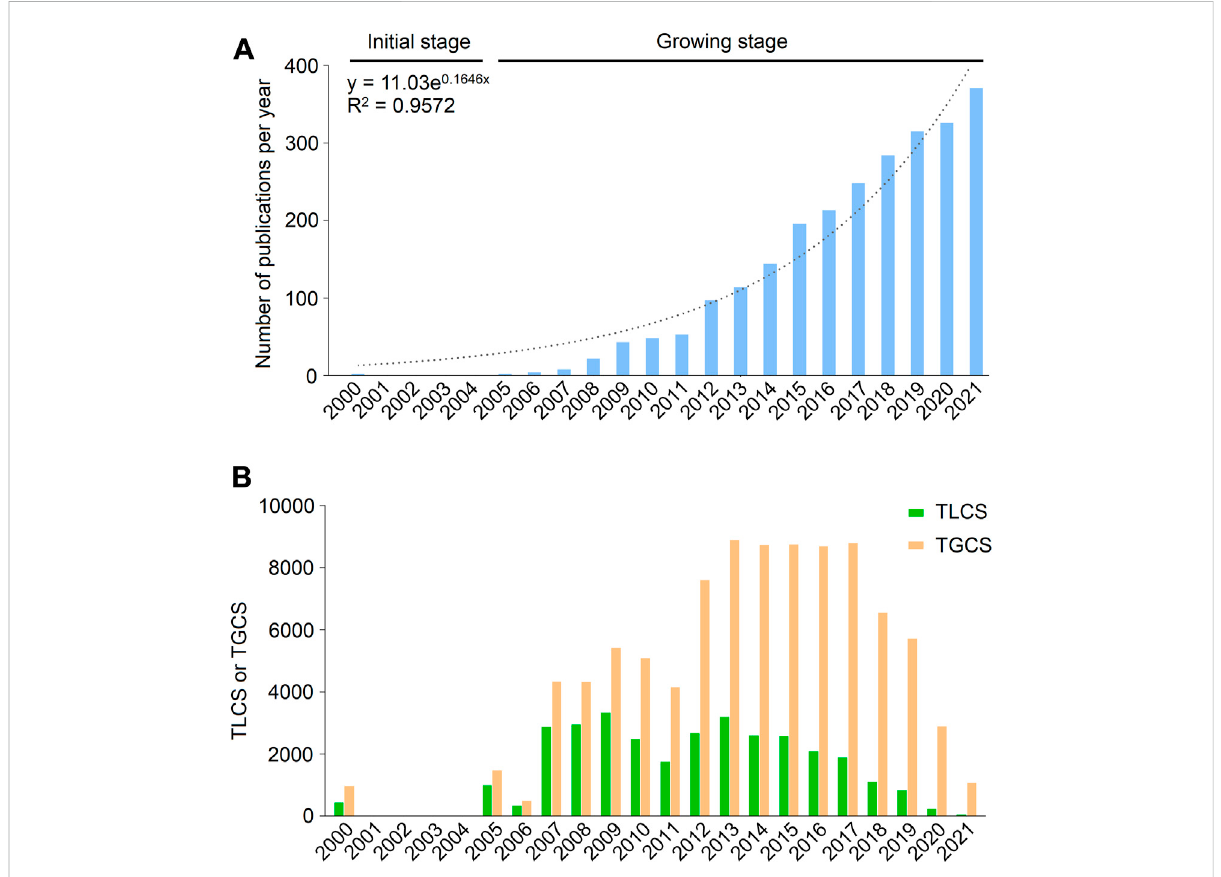
FIGURE 1 Publication outputs and citations on FGF-21 in the past 22 years. (A) Global annual production trends. Blue bars represent the number of publicationsrelatedtoFGF-21peryear,andthedottedlinerepresentsthetrend- fi ttedcurve.The fi ttingequationandthecorrelationcoef fi cients(R 2 ) are presented. (B) Annual TGCS and TLCS of